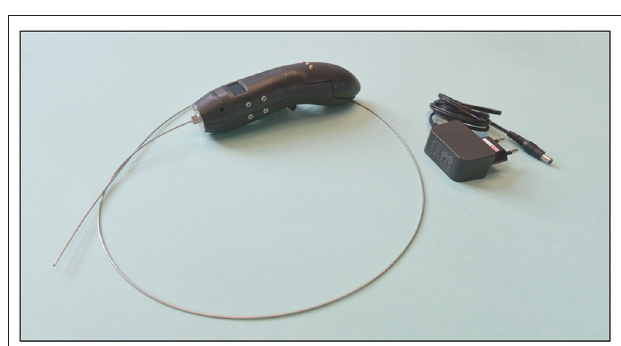
FIGURE 13 | Final developed Wave catheter